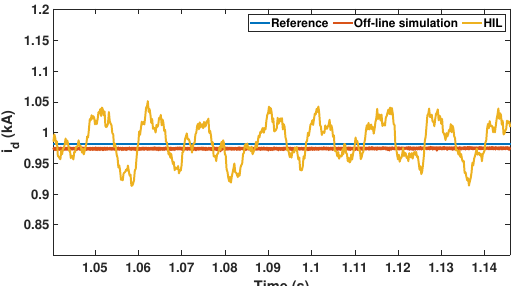
Figure 19. Experimental results of proposed method subjected to grid frequency change: () i d